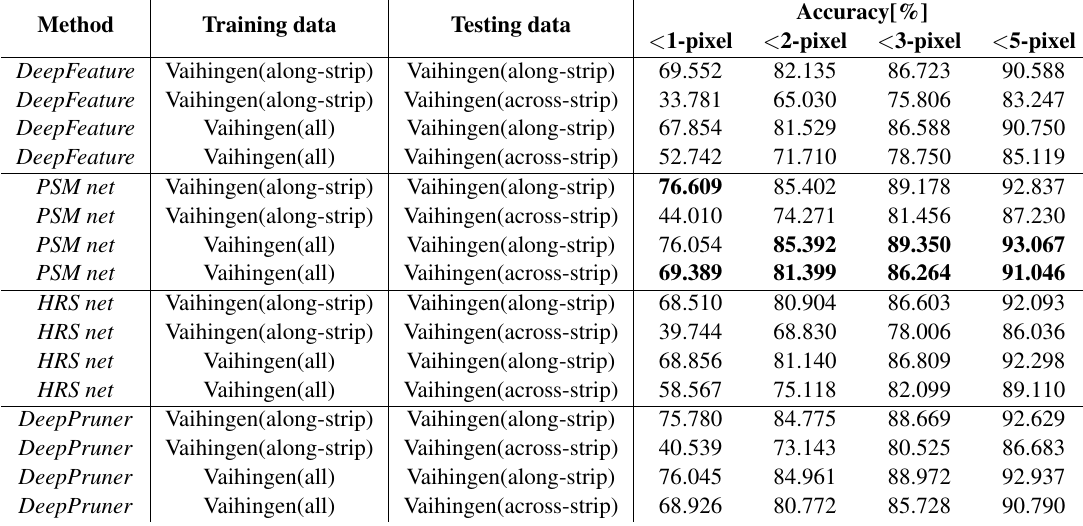
Table 6. Evaluation of deep learning methods on different stereo pair